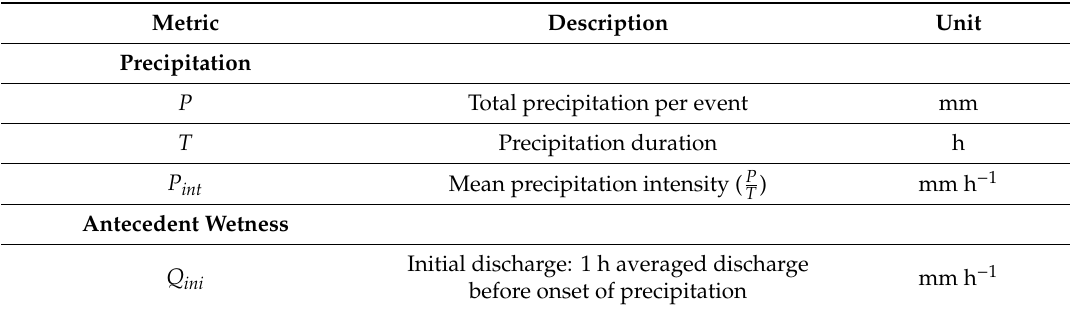
Table 1. Hydrometrics to describe precipitation, antecedent wetness, discharge characteristics, maximum event water fraction, and response time for each